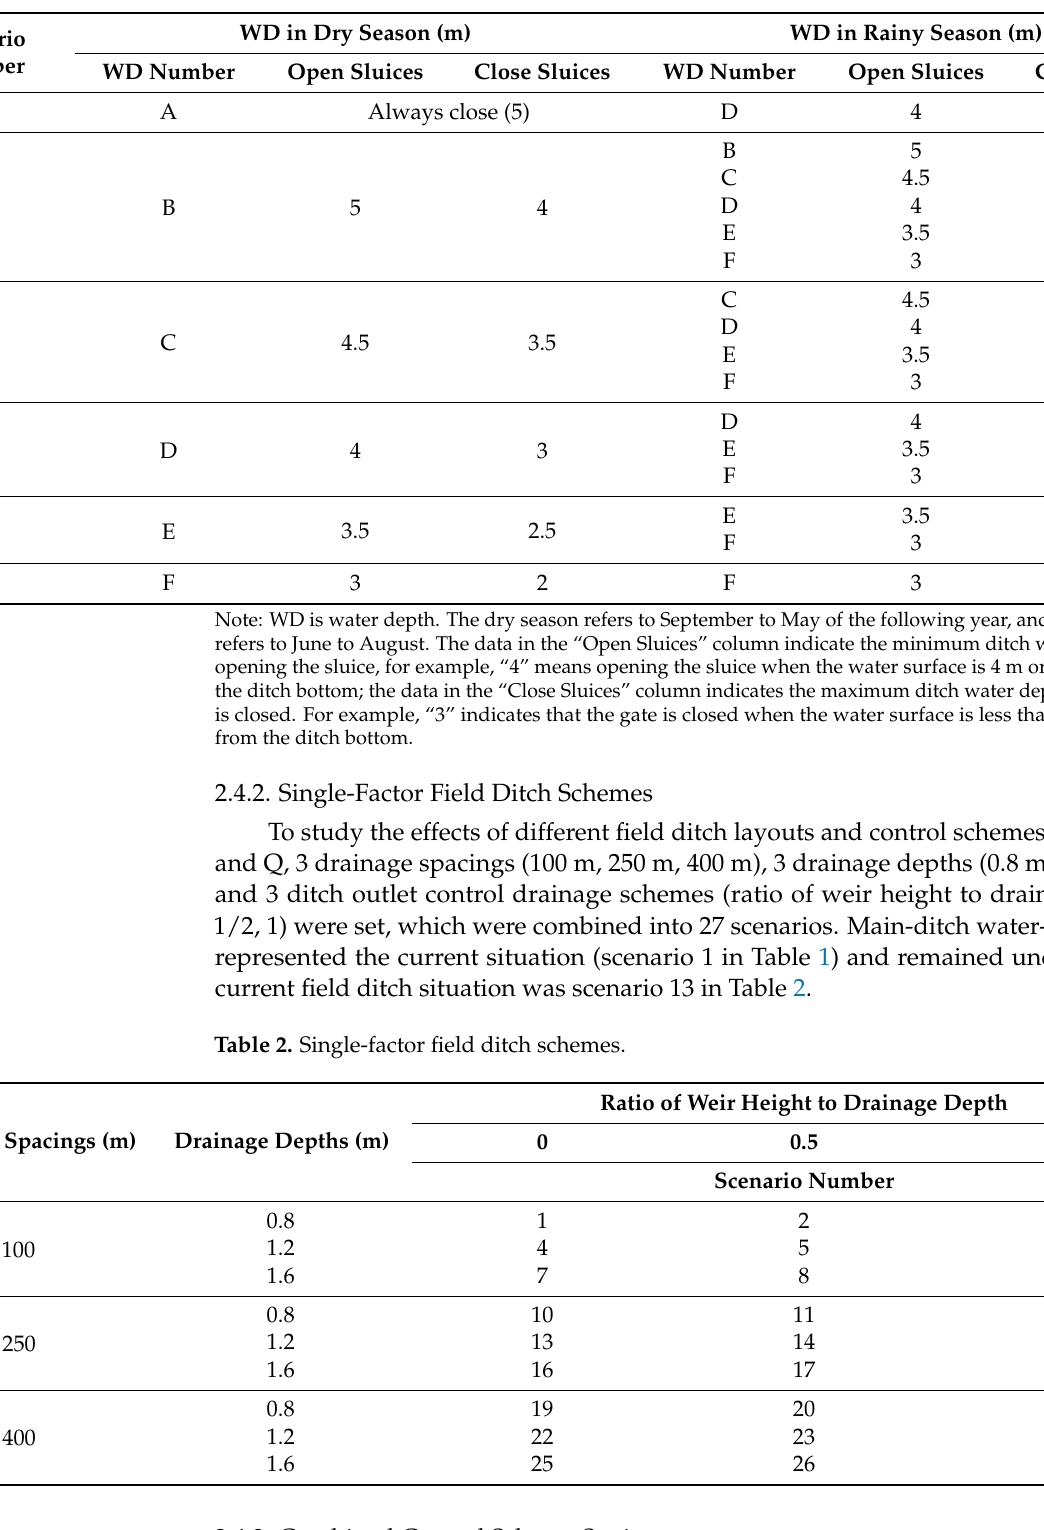
Table 1. Single-factor main ditch water depth control schemes.